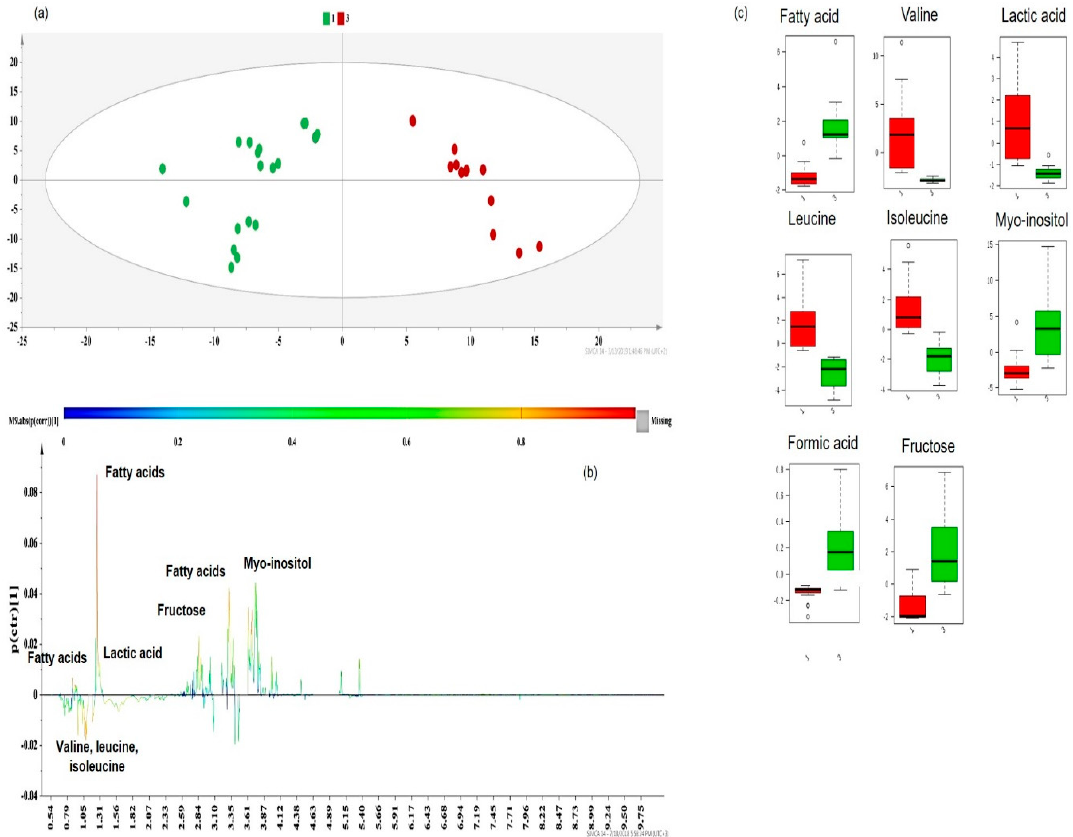
Figure 10. ( a ) OPLS-DA model of Group 1 vs. Group 3 DOE apricot extracts, Pareto scaled, where A = 1 + 1 + 0 (N = 32, R 2 Y(cum) = 0.889, Q 2 (cum) = 0.836, p < 0.05), green dots = apricot pulp samples with a low extraction yield ( ≤ 5 mg carotenoids 100 g − 1 dry sample), and red dots = apricot pulp samples with a medium extraction yield ( ≥ 15 mg carotenoids 100 g − 1 dry sample); ( b ) S-line plot of the OPLS-DA model; ( c ) box-plots of the discriminant metabolites, where red box-plots correspond to Group 1 (green dots) and green box-plots correspond to Group 3 (red dots).